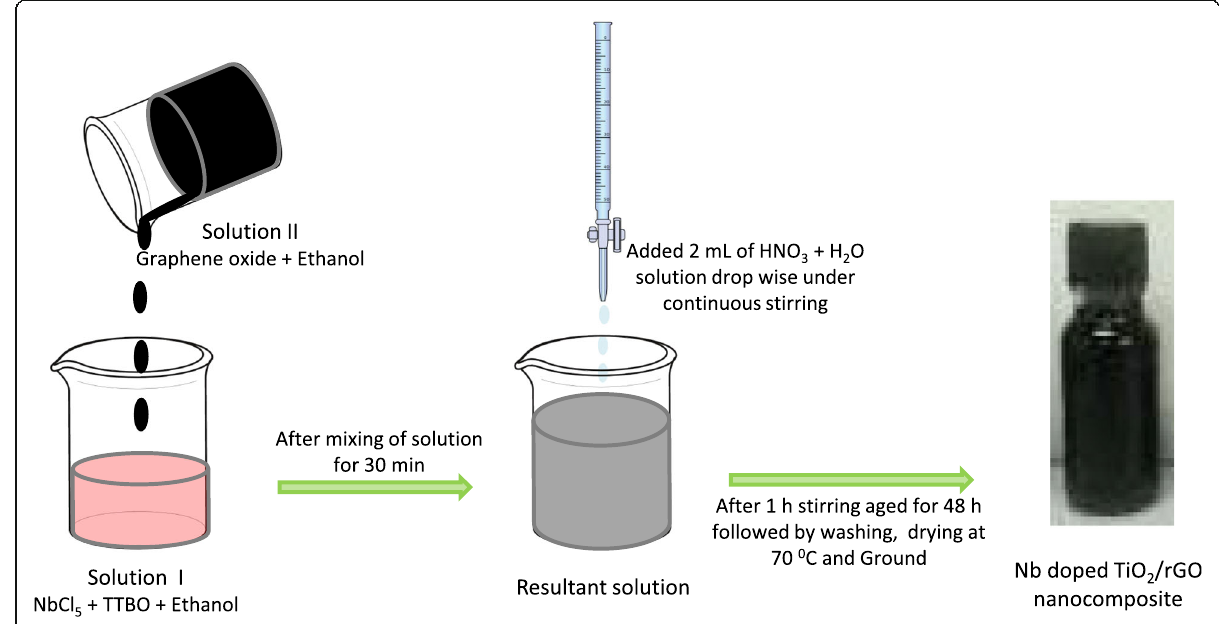
Fig. 1 Schematic representation of synthesis of Nb doped TiO 2 /rGO